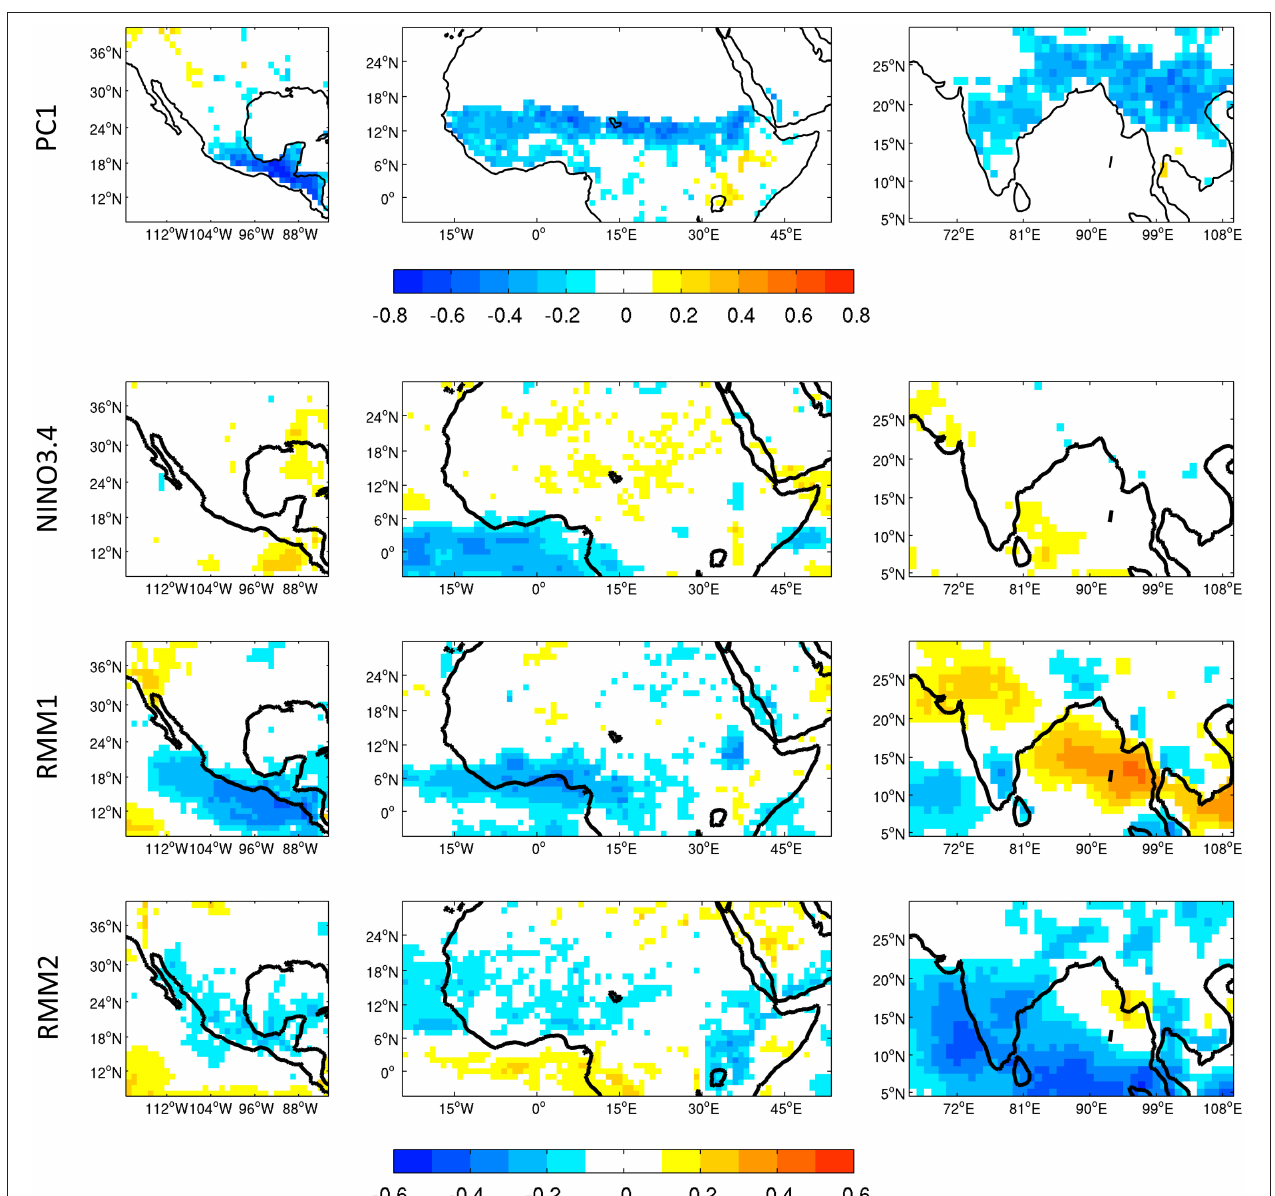
FIGURE 13 | Top panels display spatial correlation patterns of raw week 3–4 MME RPSS Principal Components (PCs) for starts during the May-Aug season. Other panels show May–Aug correlations between GPCP weekly precipitation and observed weekly Niño3.4 index (2nd raw) and MJO RMM1 (3rd raw) and RMM2 (bottom raw) indices of Wheeler and Hendon (2004). Only scores significant at 95% level of significance using Monte Carlo simulations are